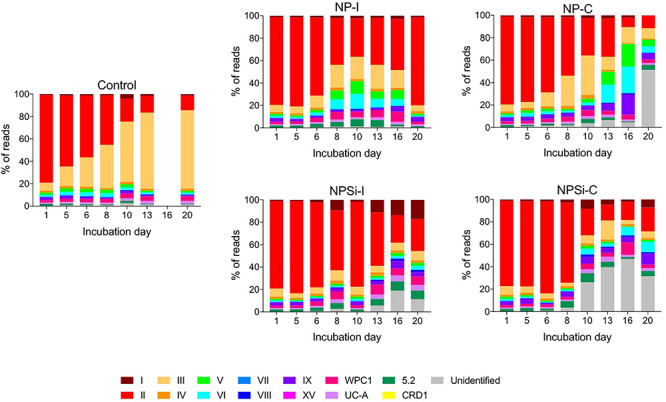
Changes over time in the different clades of Synechococcus found for control and nutrient addition treatments, according to the relative count of gene reads (%). Each color corresponds to a different clade; unidentified reads are represented as “unidentified” and colored gray (see legend).